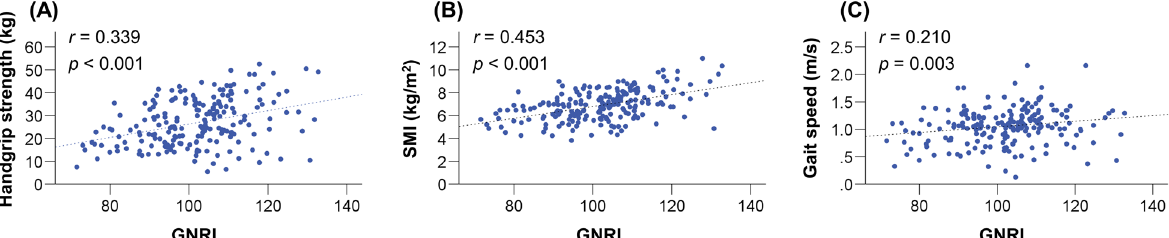
Figure 2. Correlations between Geriatric Nutritional Risk Index (GNRI) and handgrip strength, skeletal muscle mass index (SMI), and gait speed. GNRI values were significantly and positively correlated with ( A ) handgrip